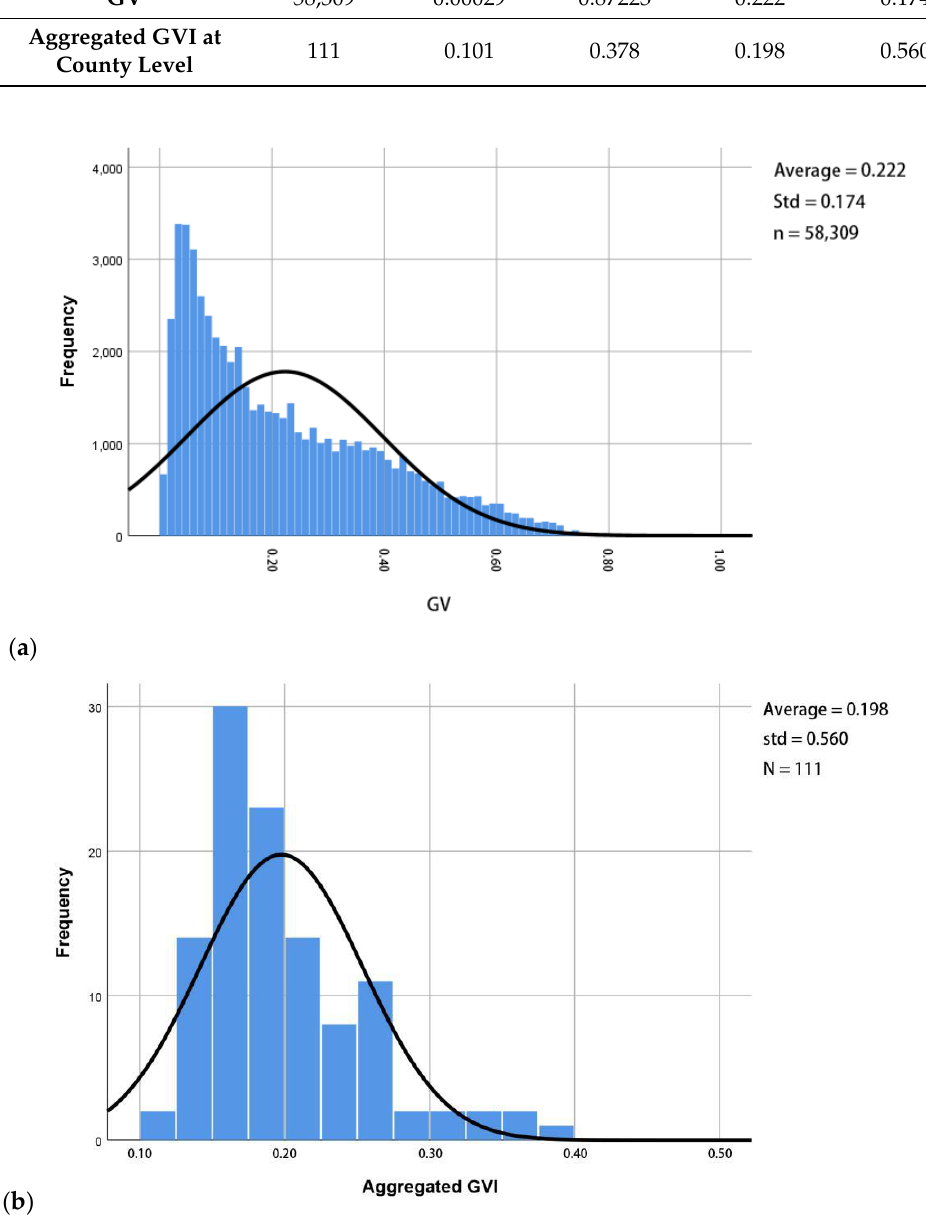
Figure 8. ( a ). Descriptive statistics of point green-view values; ( b ) Descriptive statistics of green-view value at county or jiedao level.